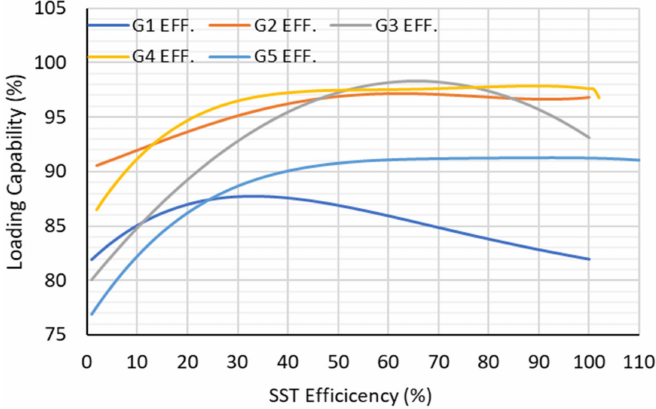
Figure 6. Efficiency vs. loading capability characteristics of